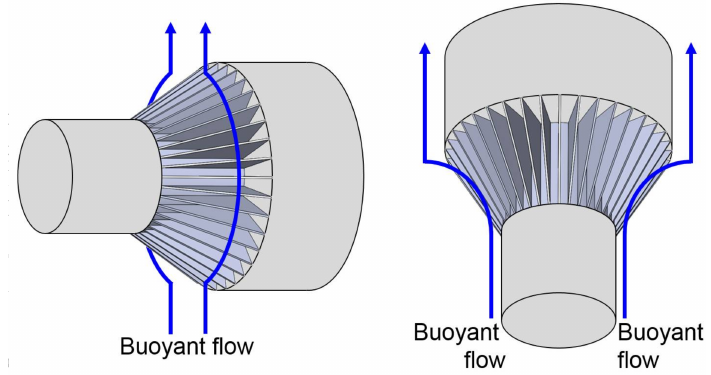
Figure 17. Finned cylinders when sides of fins are also blocked and insulated.